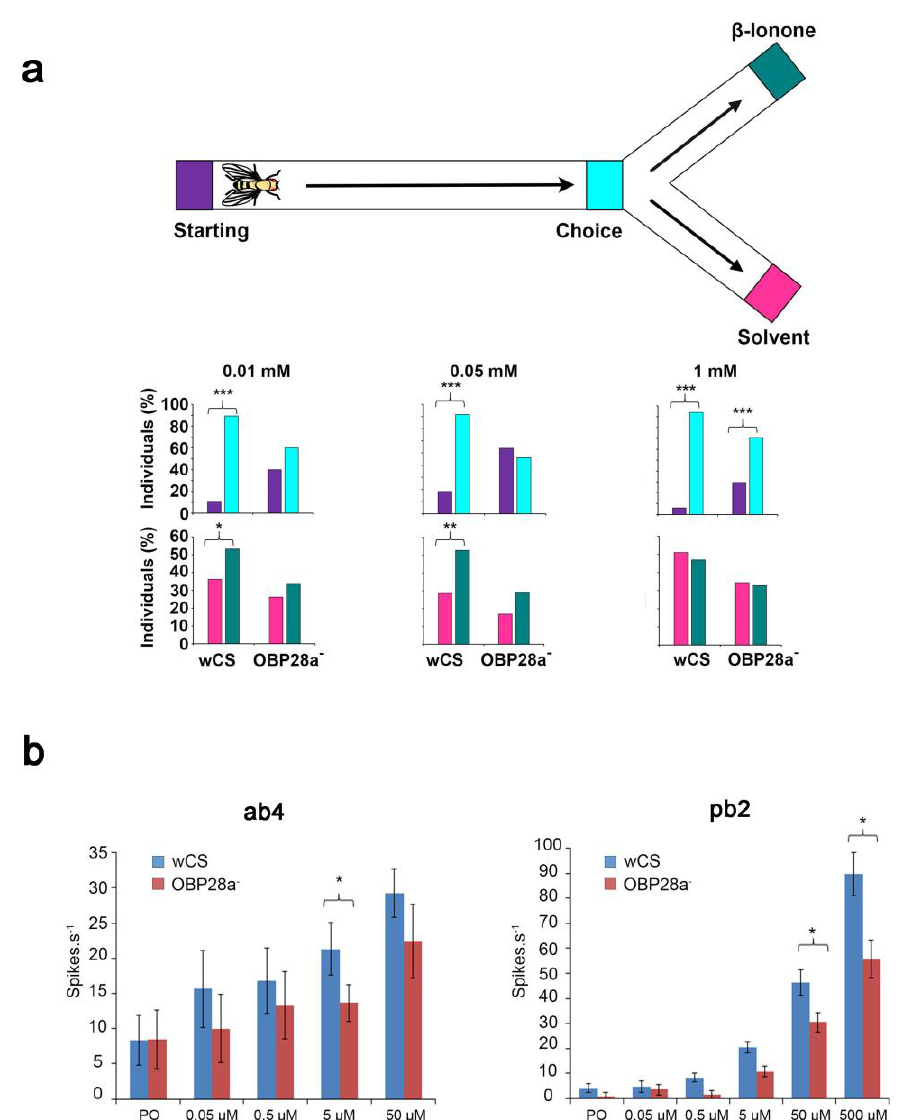
Figure 8. Deletion of OBP28a changes the threshold of detection of β-ionone. ( a ) Olfactory responses of control (wCS) and OBP28a mutant (OBP28a - ) flies to three concentrations of β-ionone. Top: Illustration of the Y-shaped olfactometer used to test the fly olfactory preference for β-ionone. The position of the fly in the device is noted at two positions: first its locomotion in the straight tube (between the starting point (purple) and the choice point (blue)); second its preference relative to the arm chosen (either β-ionone (green) or the solvent (pink)). Bottom: percentages of control (wCS) and OBP28a mutant (OBP28a - ) flies in each section of the device: the top histograms show the position in the starting tube and the bottom histograms show the arm chosen. *** p < 0.001; ** p < 0.01, Fisher test. ( b ) Electrophysiological responses of ab4 and pb2 sensillum of control (wCS) and OBP28a mutant (OBP28a - ) flies to β-ionone in paraffin oil solvent. The responses are shown to 0.5-s pulses of increasing concentrations of β-ionone. * p < 0.05, ANOVA, Kruskal–Wallis, Dunn’s post hoc test. PO paraffin oil. Adapted from [94].